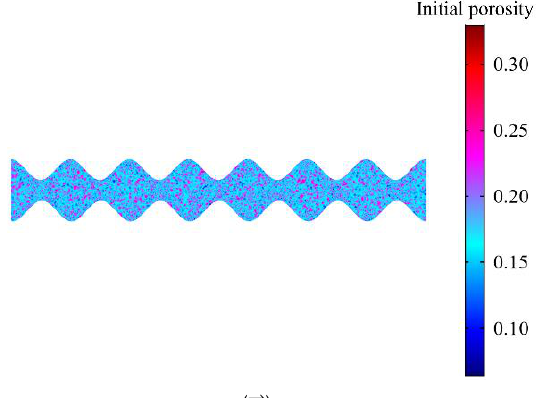
(cid:18) → (cid:19) ϕ X obeying Weibull